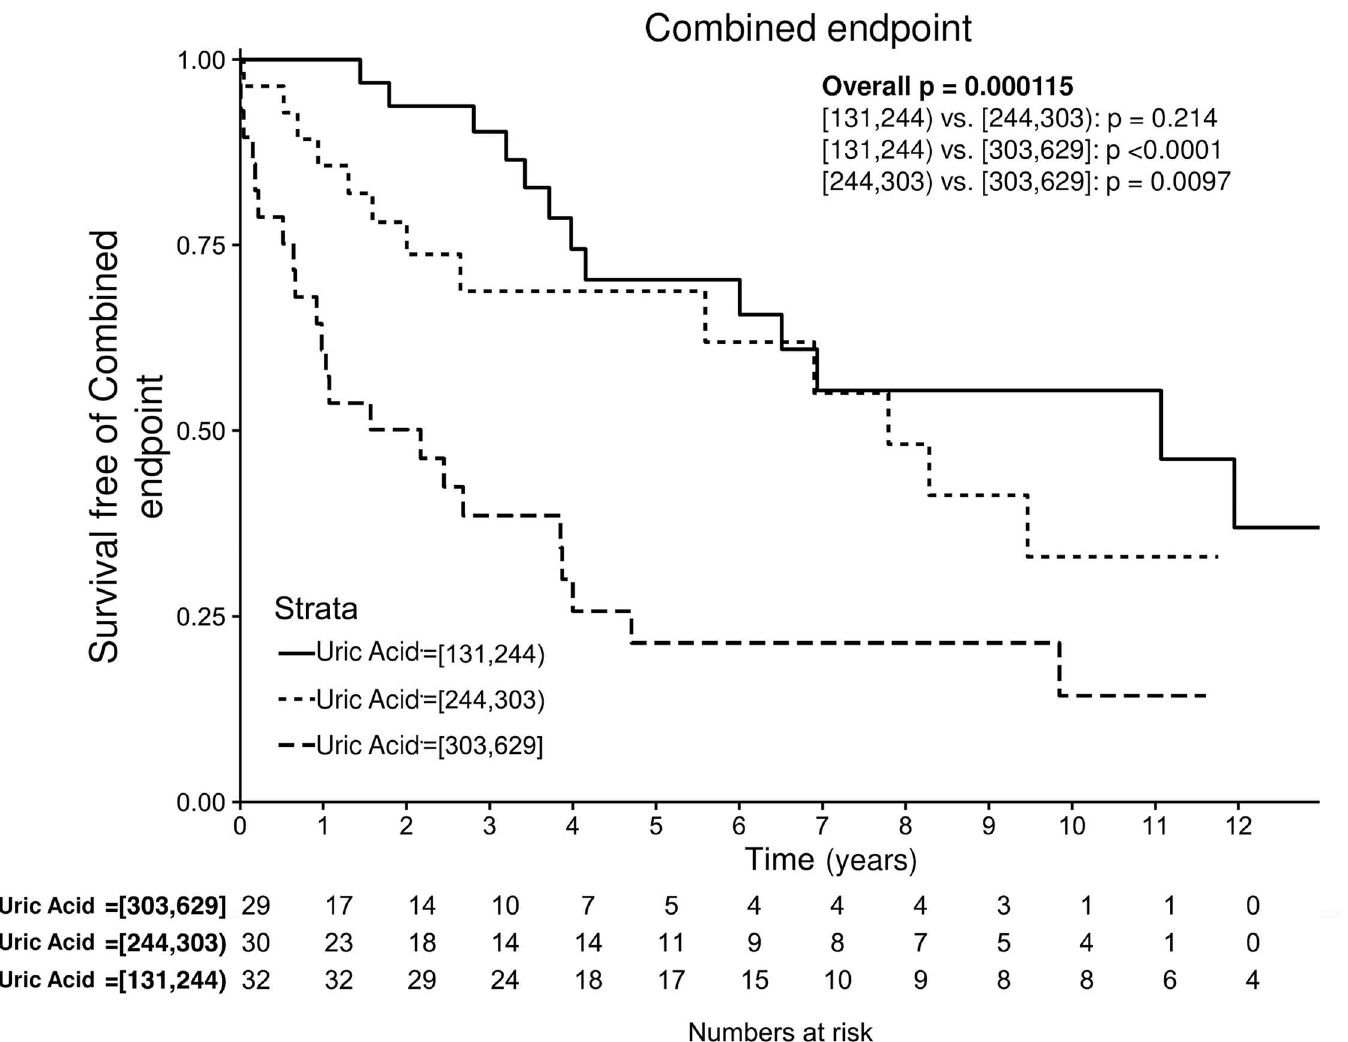
Fig 1. Kaplan-Meier analysis of combined endpoint according to tertiles of UA. Patients with higher UA levels had significantly worse primary outcome. This result remainedindependently associatedafter correcting for age, genderand estimated GFR (p =